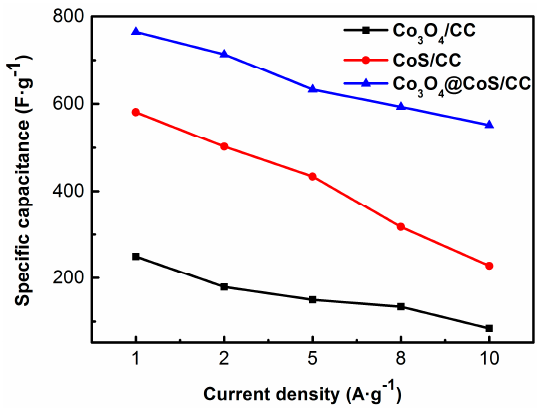
Figure 7. Specific capacitance curves of Co 3 O 4 /CC, CoS/CC and Co 3 O 4 @CoS/CC at different current densities.